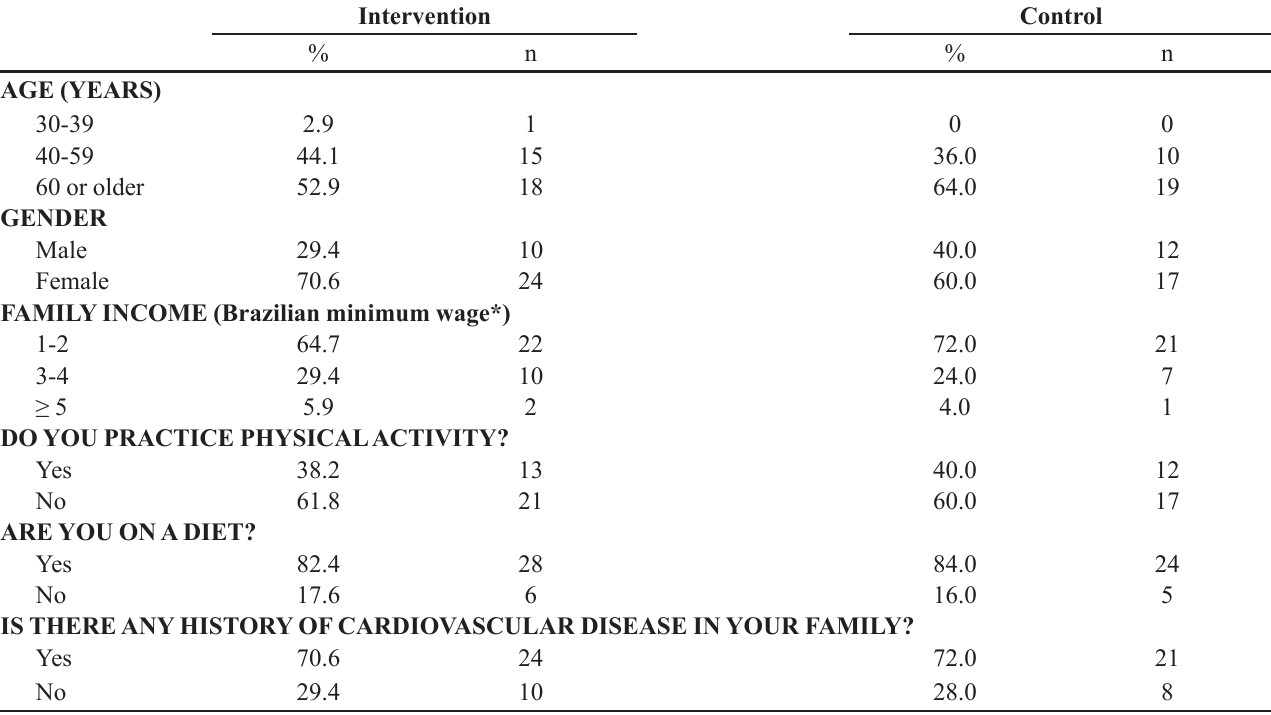
TABLE II – Socio-economic, lifestyle and cardiovascular disease family history of patients from the Control and Intervention groups Intervention Control